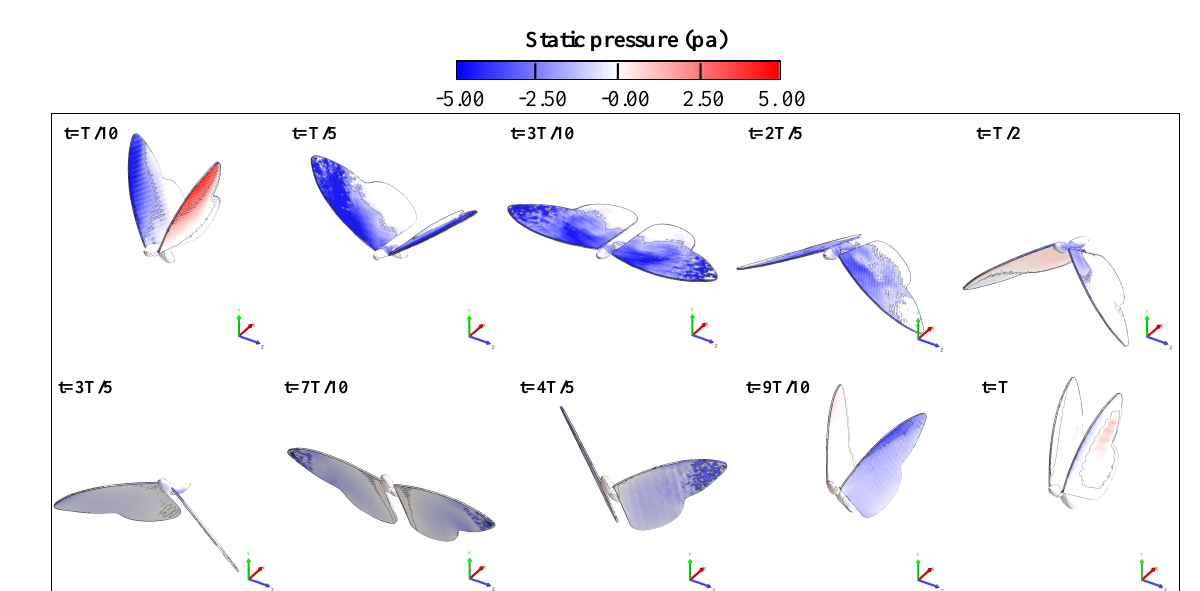
Figure 15. Surface pressure distribution of one butterfly flapping cycle. The top row represents snapshots during the DS at ˆ t = 0.1, 0.2, 0.3, 0.4, and 0.5, respectively. The bottom row represents snapshots during the DS at ˆ t = 0.6, 0.7, 0.8, 0.9, and 1.0,